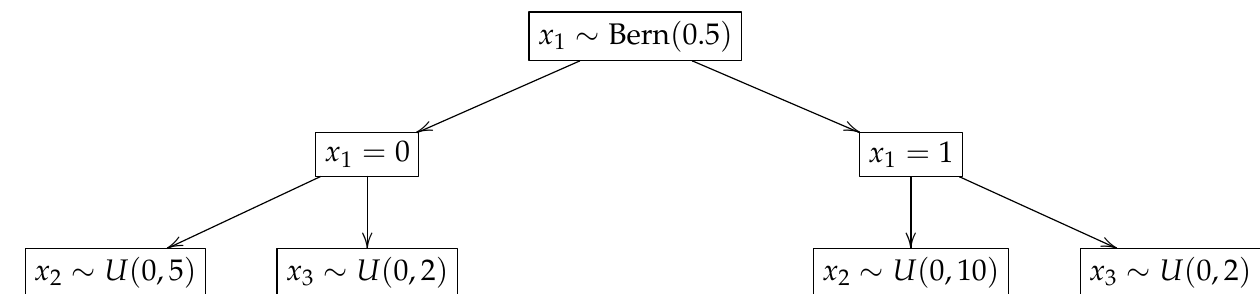
Figure 2. Scheme to draw the covariates in the simulation study. Bern (0.5) denotes the Bernoulli distribution with probability 0.5 and U ( a , b ) denotes the uniform distribution on ( a , b